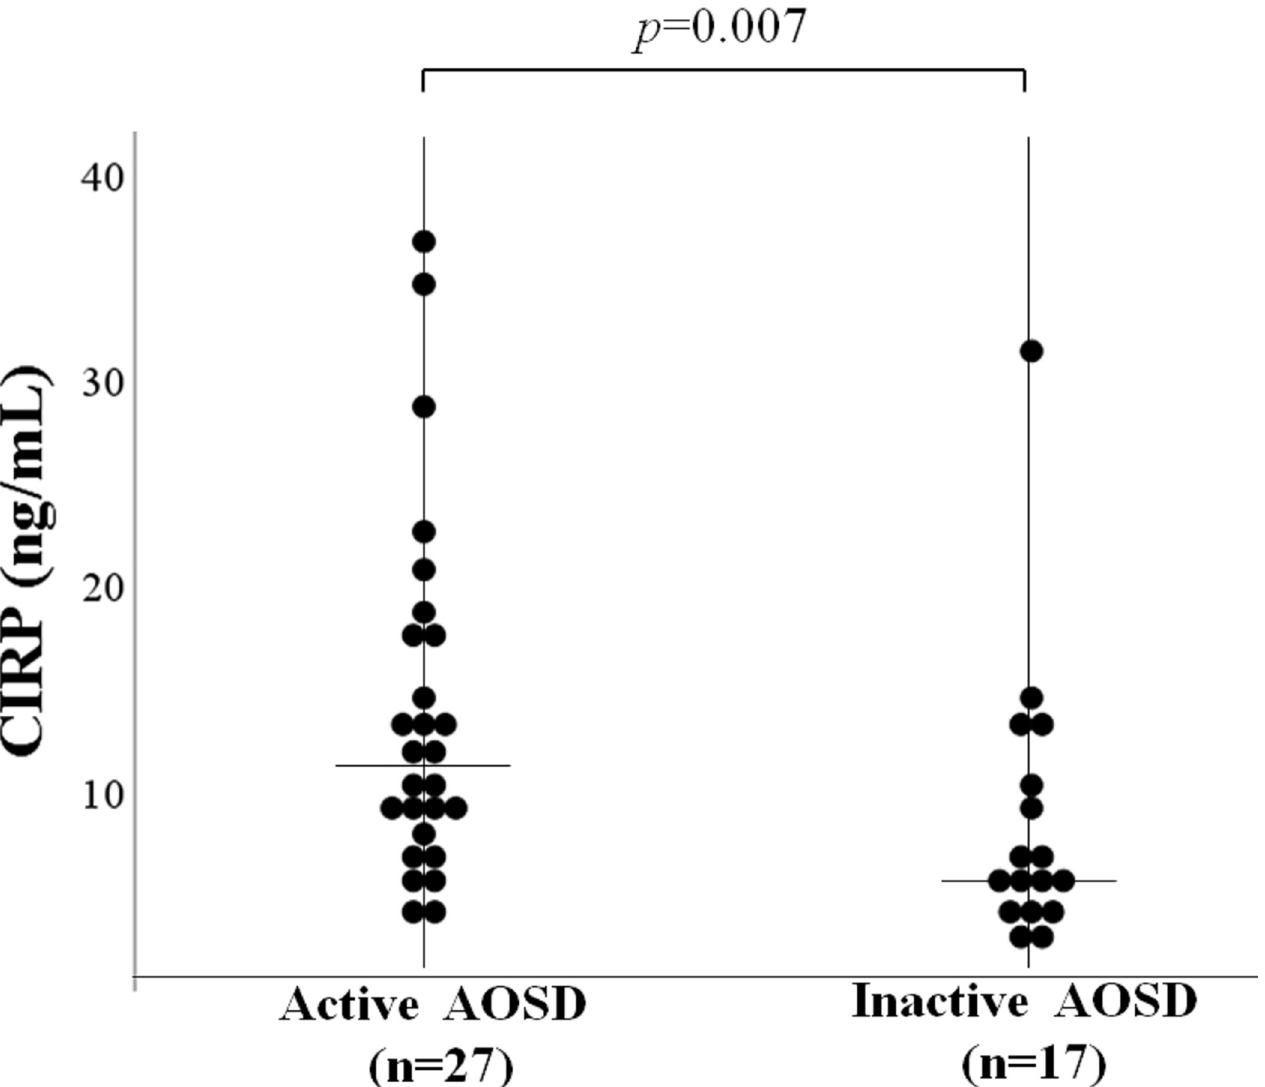
Fig 2. Serum levels of CIRP levels between active and inactive AOSD patients. Serum levels of CIRP were significantly higher in active AOSD patients than those in inactive AOSD patients. Inactive AOSD is defined when Pouchot’s score is below 3 points. Results were presented with median and were compared by the Mann-Whitney U